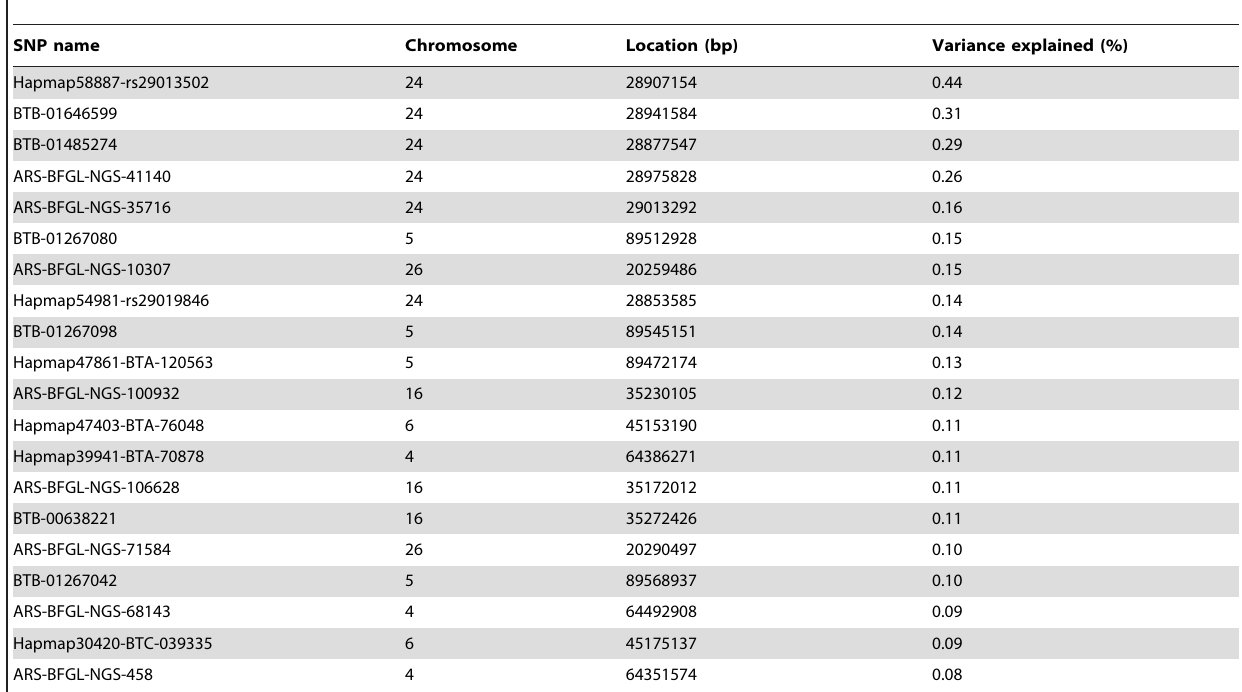
Table 3. The 20 loci with the largest proportion of SNP variance explained for rectal temperature using 5-SNP sliding